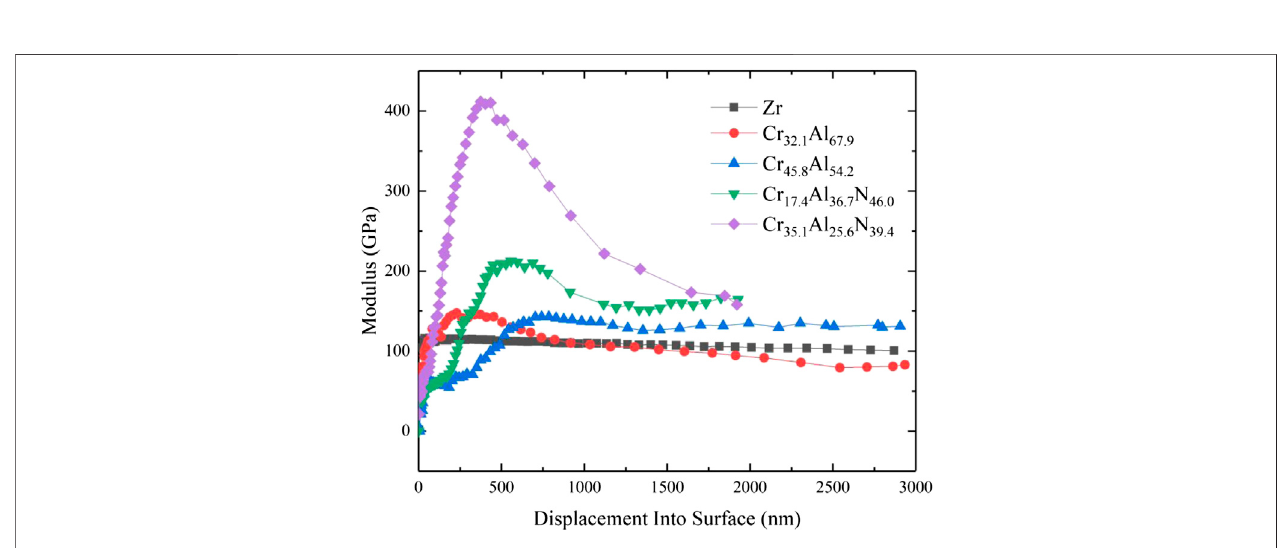
FIGURE 11 | Relationship of Young's modulus-indentation depth for Zr-4 and coatings.